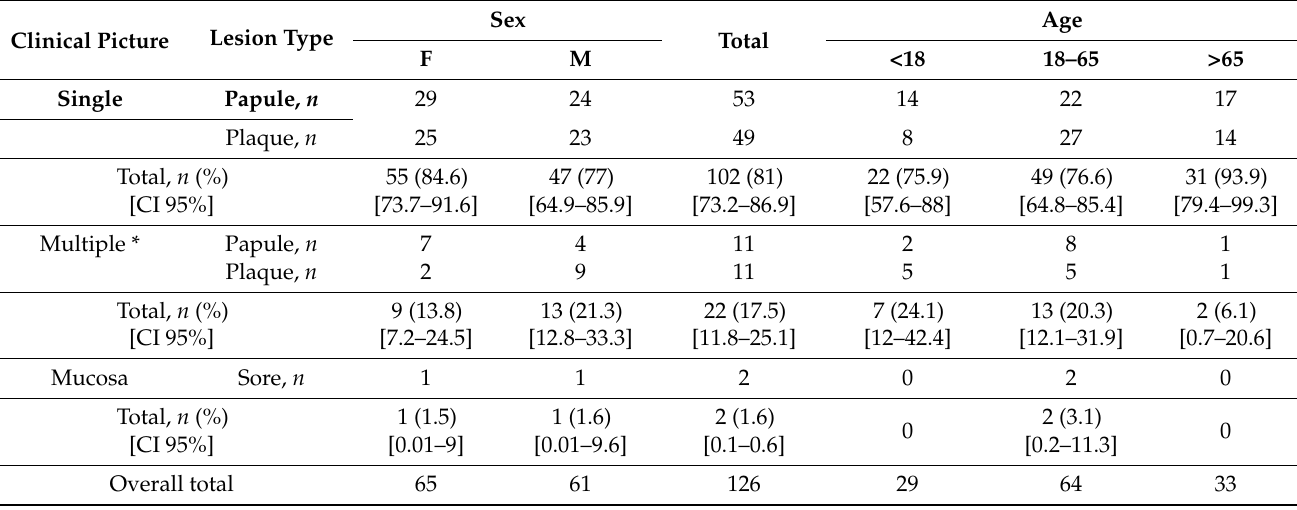
Table 4. Type of lesion according to the sex and age of patients ( n = 126).